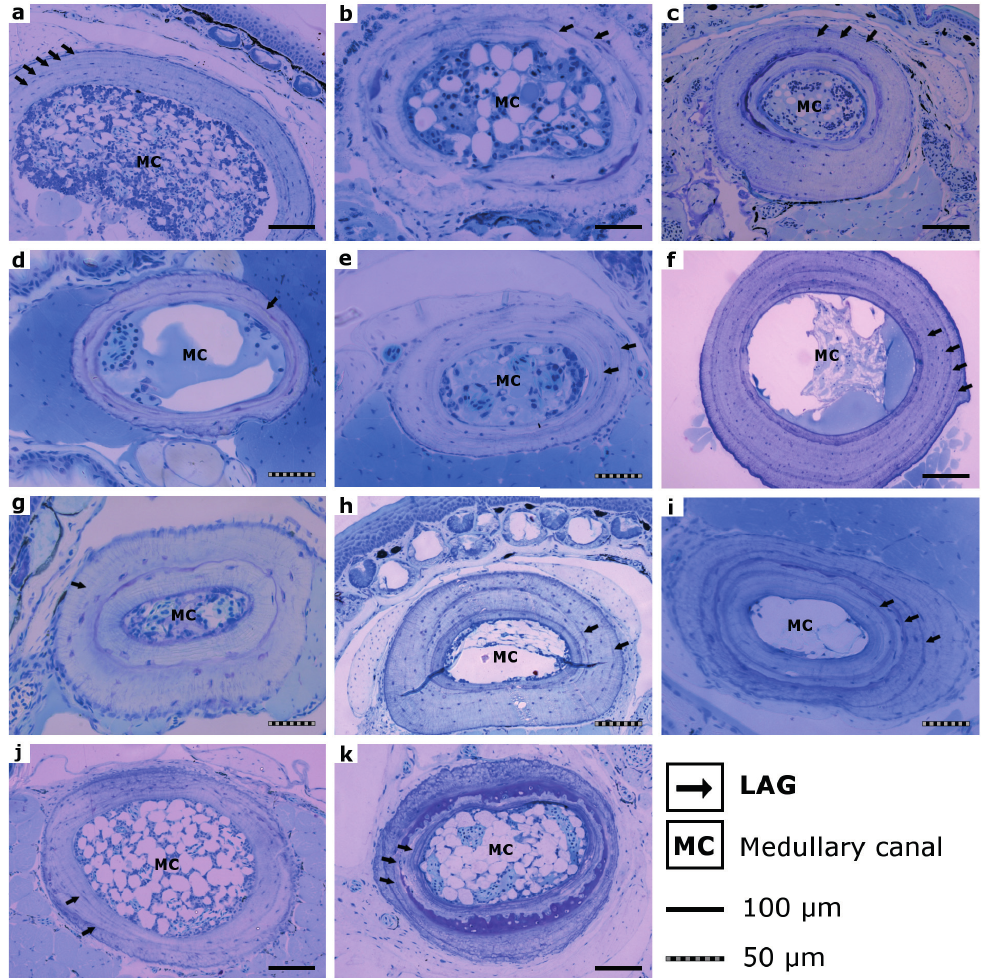
Figure 1 - Cross-sections of the falanges showing the lAgs in ( a ) Limnomedusa macroglossa; ( b ) Melanophryniscus atroluteus ; ( c ) Rhinella fernandezae ; ( d ) Vitreorana uranoscopa ; ( e ) Boana pulchella ; ( f ) Phyllomedusa iheringii ; ( g ) Crossodactylus schmidti ; ( h ) Leptodactylus fuscus ; ( i ) Physalaemus cuvieri ; ( j ) Elachistocleis bicolor ; and ( k ) Odontophrynus americanus